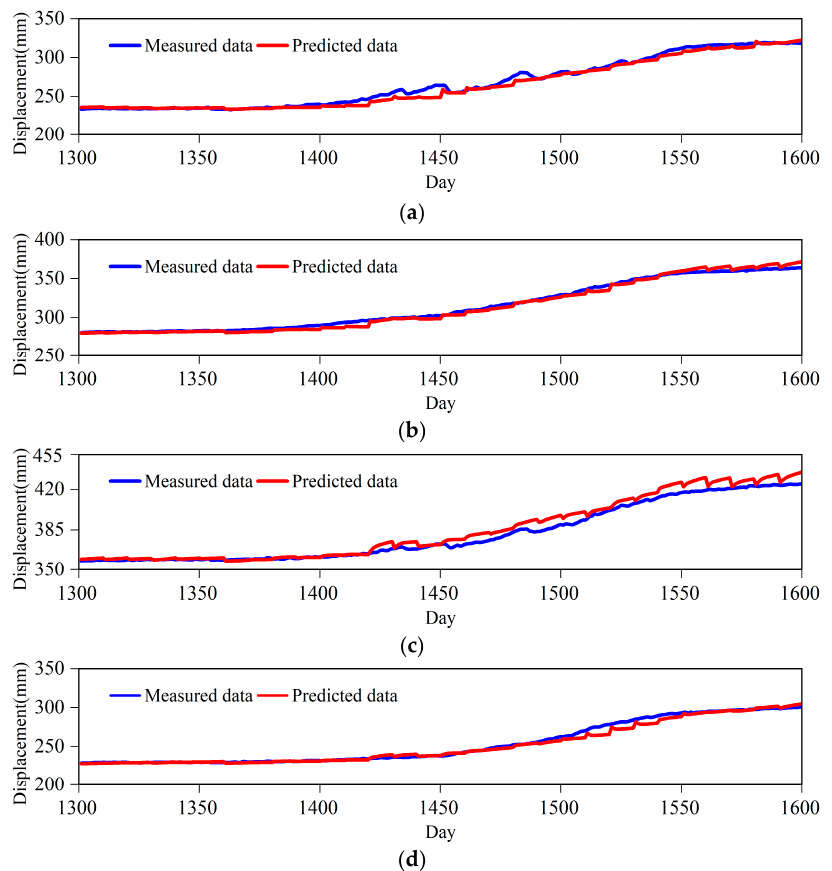
Figure 8. Prediction of displacement data (RM40%). ( a ) Point SZY-02; ( b ) point SZY-03; ( c ) point SZY-06; ( d ) point SZY-08. The blue curve represents the measured data and the red curve represents the predicted data.